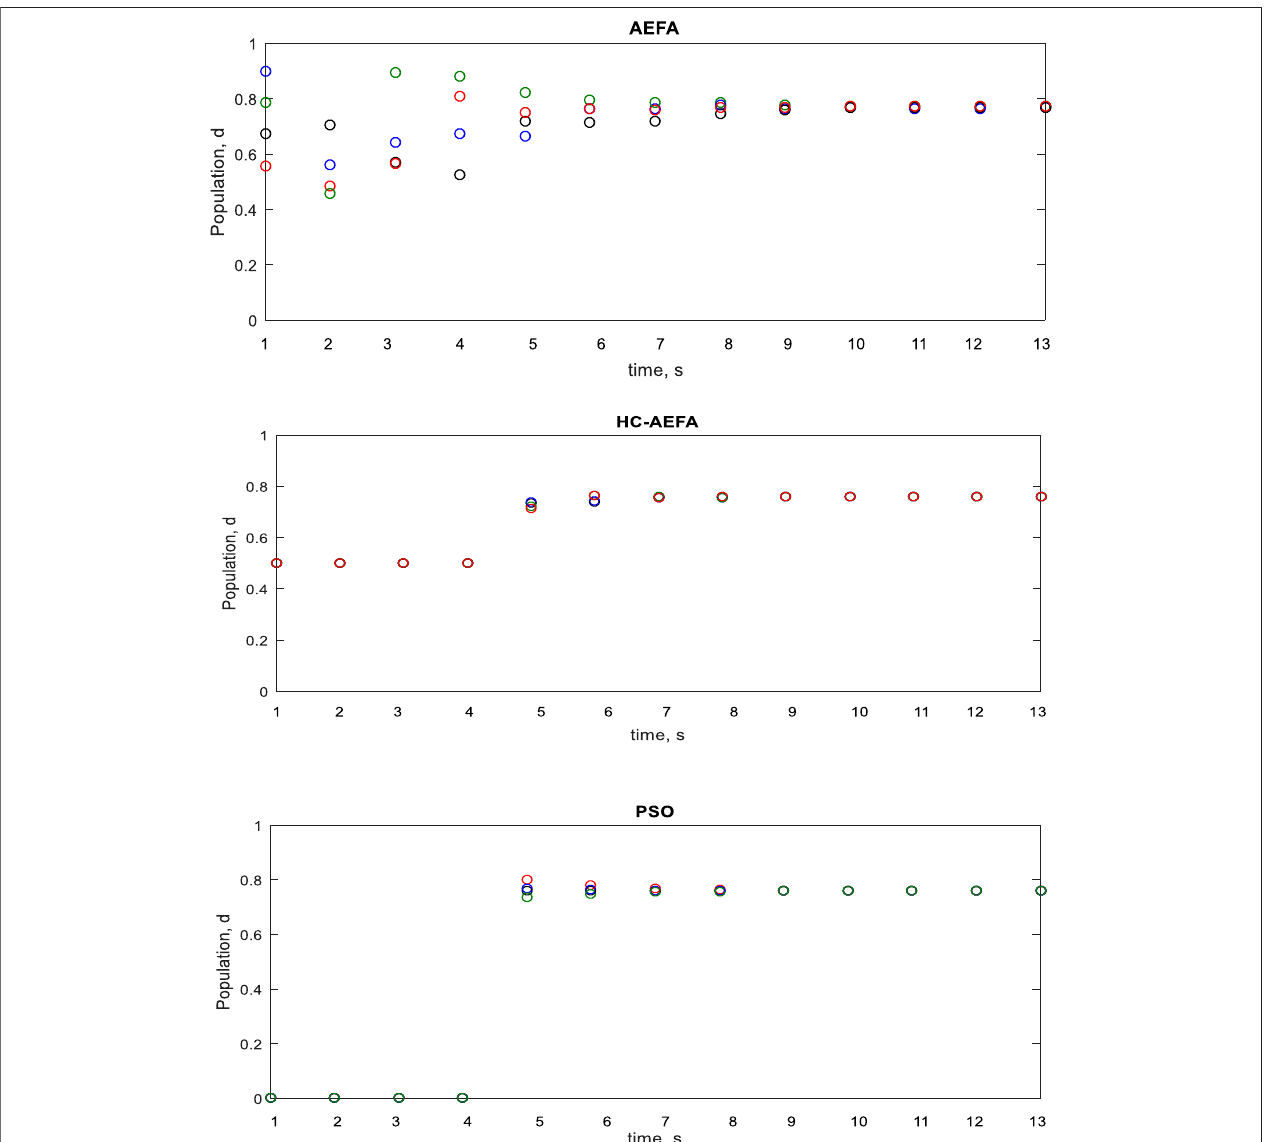
FIGURE 12 | Particles ’ positions in each iteration for the HC-AEFA, HC, AEFA, and PSO methods in the case of the third pattern.